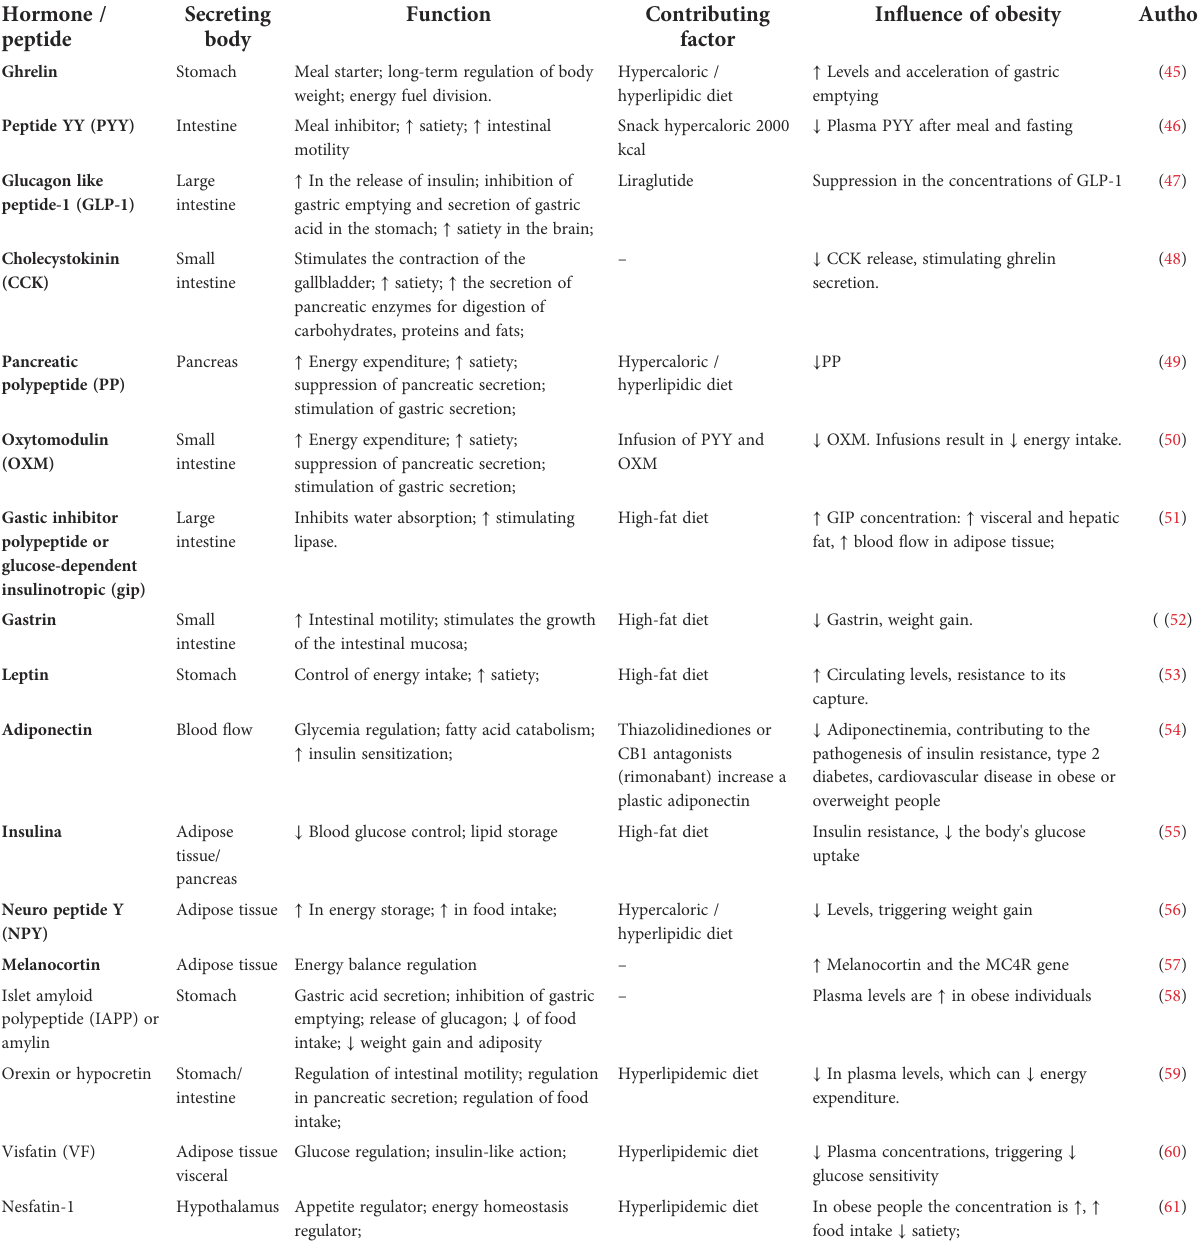
TABLE 1 Functions of hormones/peptides and possible changes due to